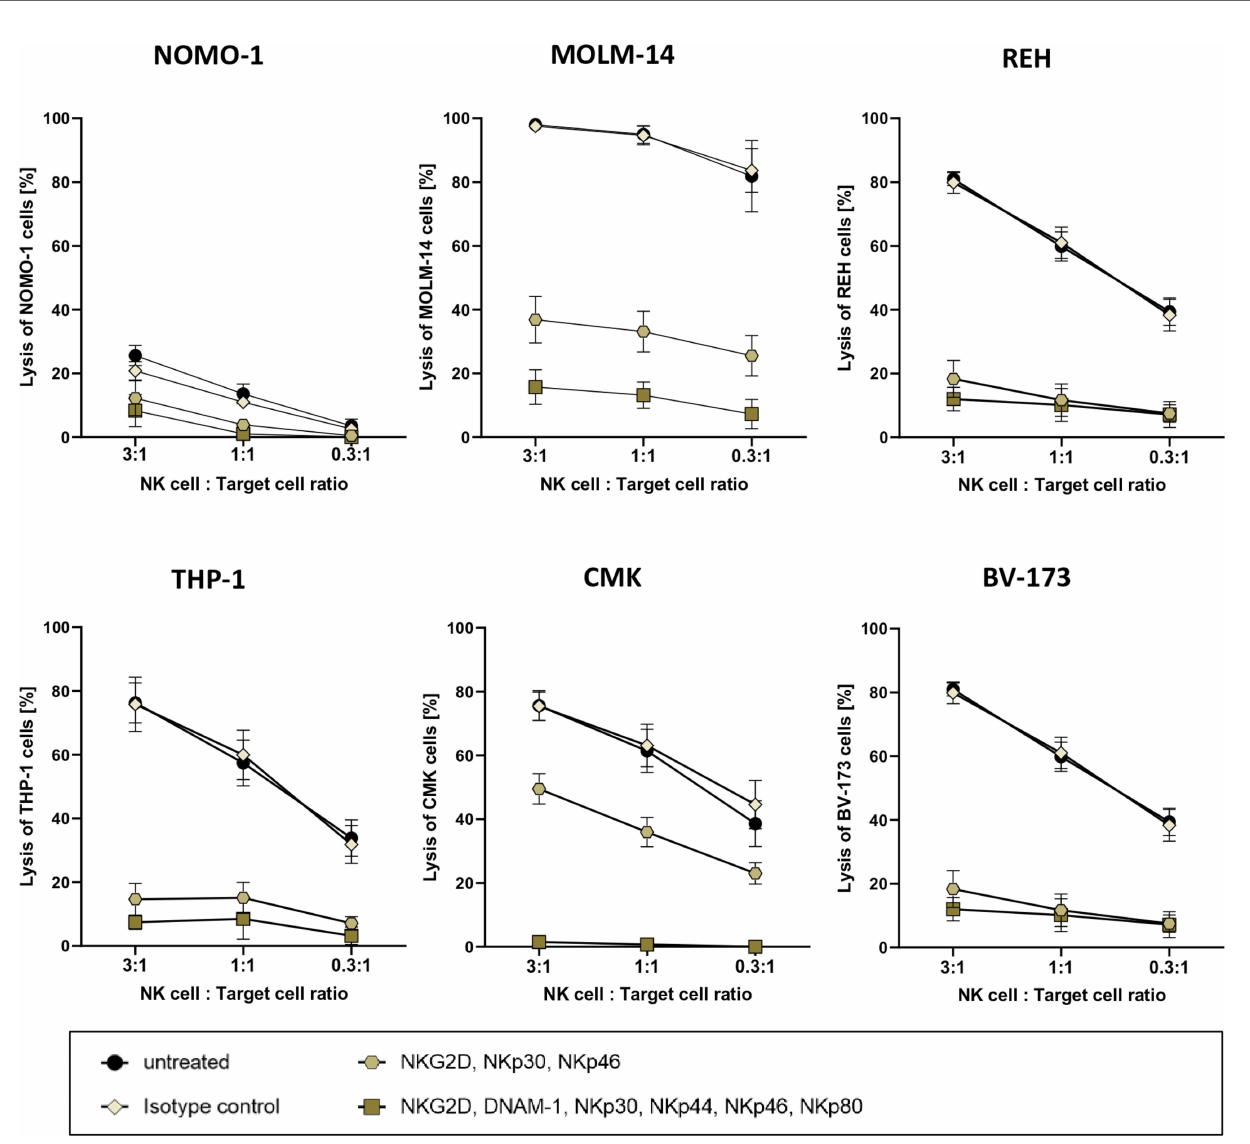
FIGURE 3 | Cytotoxic potency of activated primary human NK cells against acute leukemia. Killing of various leukemic cell lines by activated primary human NK cells was analyzed by co-culture of NK cells and target cells at several ratios. Activated primary human NK cells were incubated with blocking antibodies against activation receptors (as stated) and co-cultured with NOMO-1, MOLM-14, REH, THP-1, CMK, and BV-173 cells at various ratios to determine cytotoxic activity of NK cells. After 16 h of co-incubation at 37°C, the cytotoxicity of the treated and untreated NK cells was analyzed via fl ow cytometry, and the degree of the cell lysis was analyzed as described in the Material and Methods . The graphs represent mean ± SEM of four biological